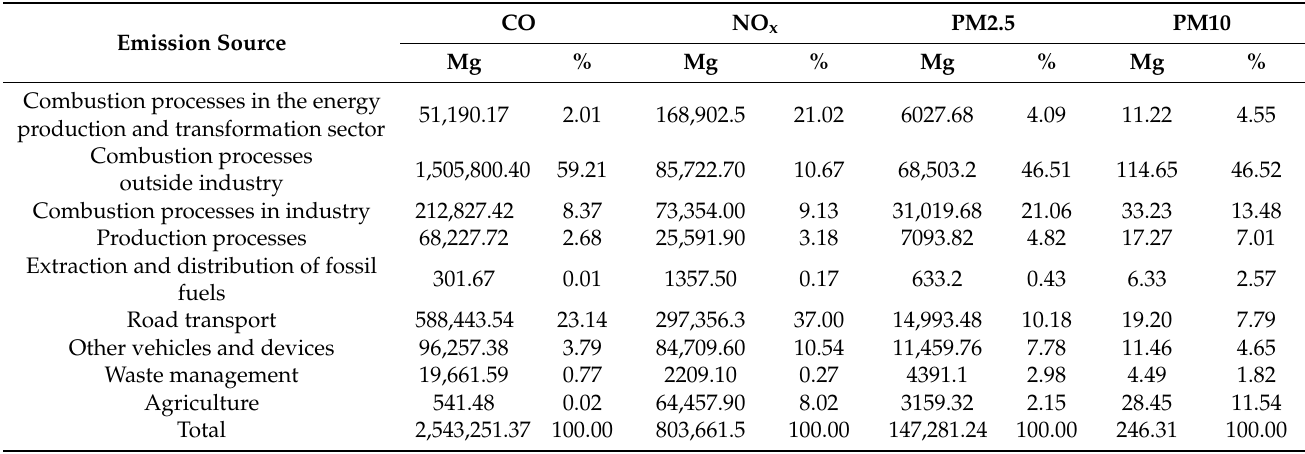
Table 2. The share of emissions of carbon oxides and nitrogen oxides as well as particulate matter PM2.5 and PM10 in Poland in 2017 by SNAP (Selected Nomenclature for sources of Air Pollution) category